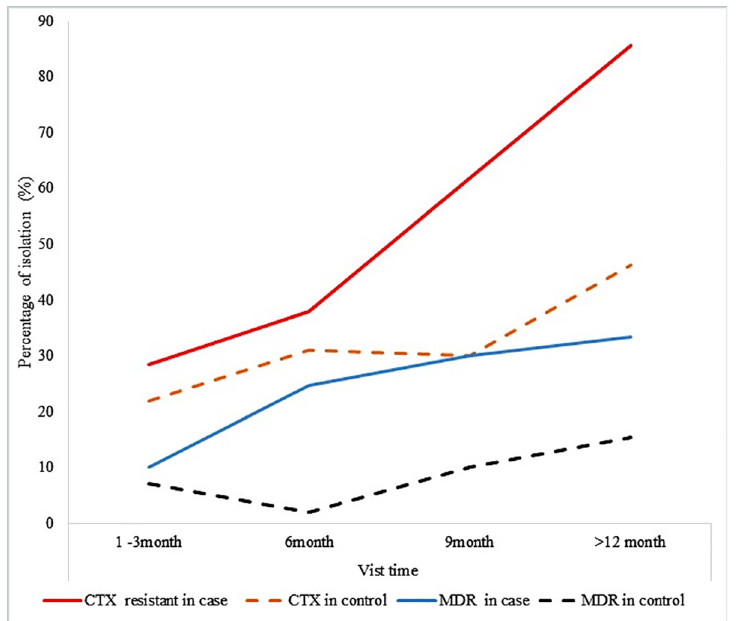
Fig 1. Percent of CTX resistant and MDR pneumococci among colonized